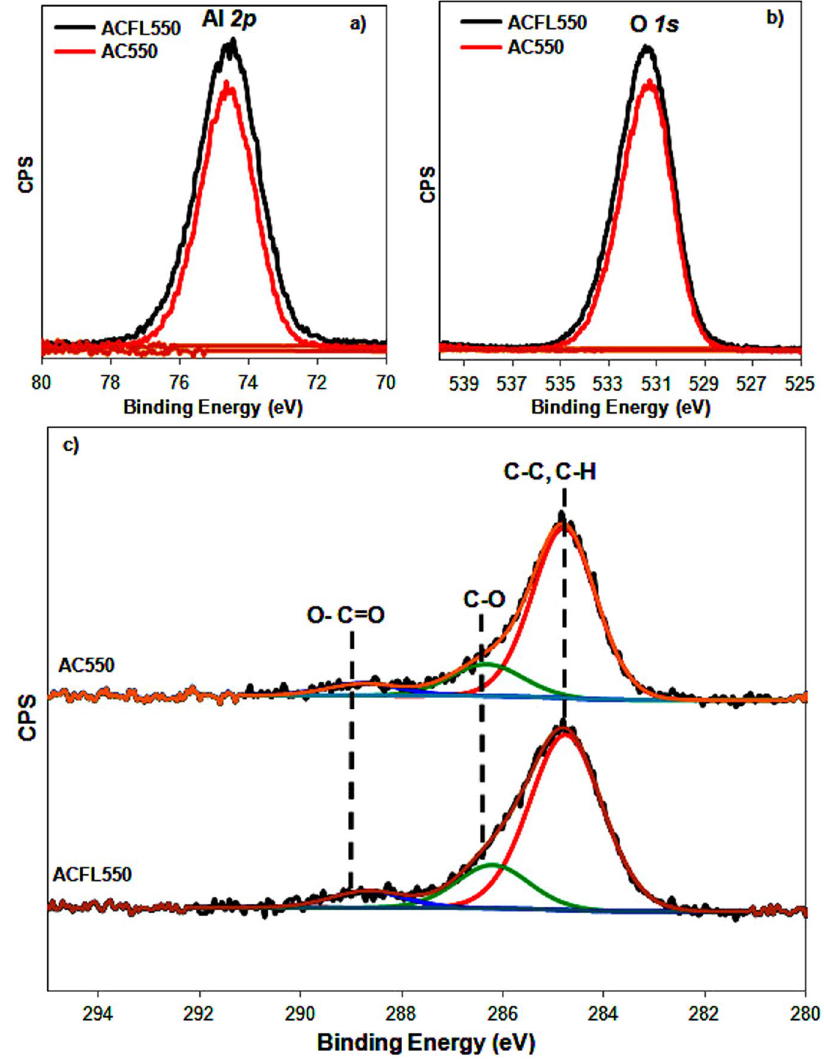
Figure 2. XPS of ACFL550 and AC550 catalysts ( a ) Al 2p , ( b ) O 1s and ( c ) adventitious carbon C 1s